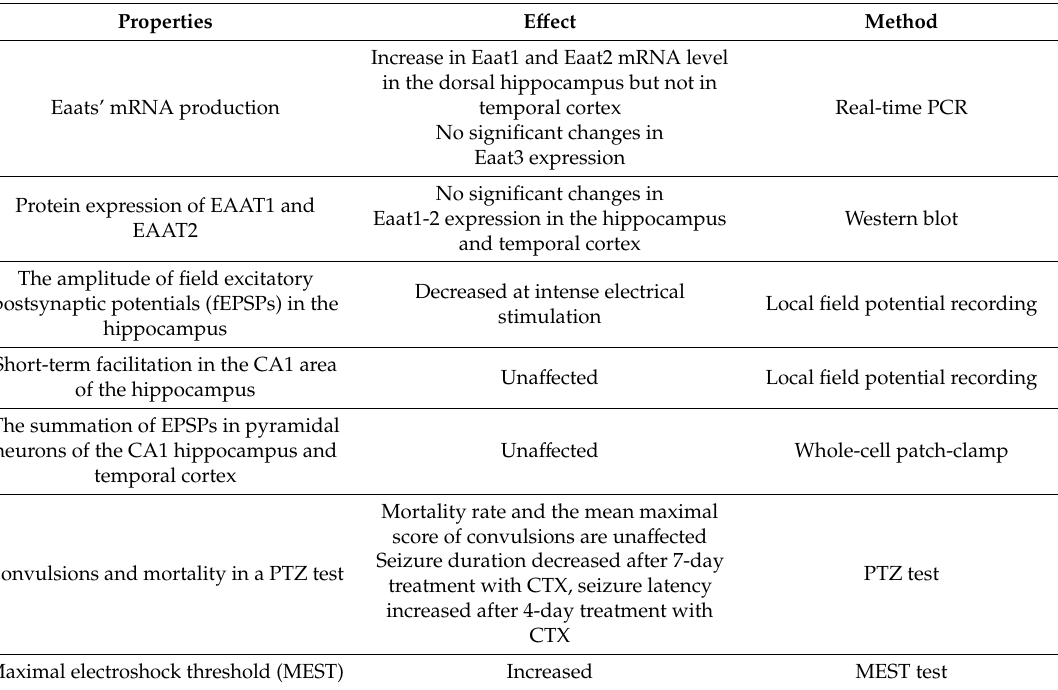
Table A2. Summary table of e ff ects of CTX